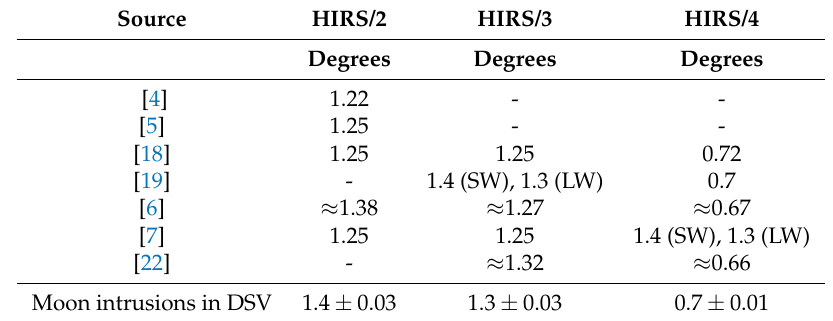
Table 1. Diameter of the field of view of different versions of HIRS according to different sources. The values from the NASA and OSCAR web pages are approximate, because they needed to be converted from km at s.s.p. to